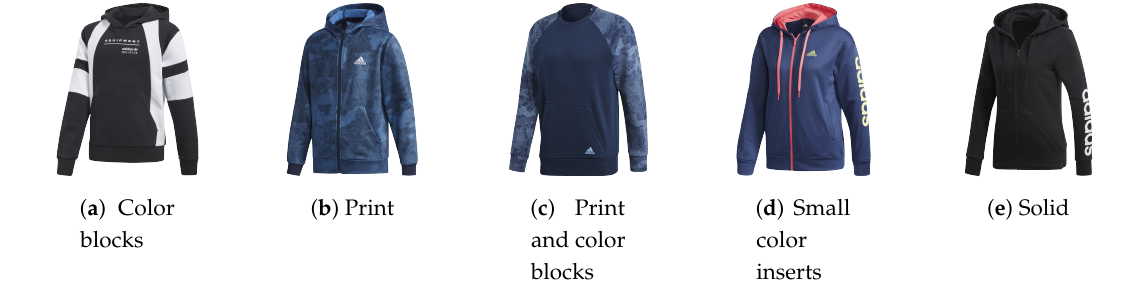
Figure 2. Prints and clothing patterns’ examples.